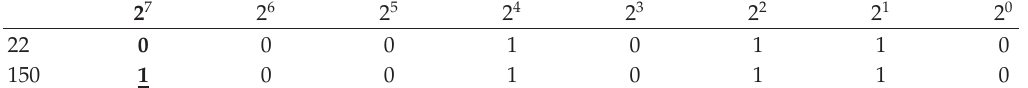
Table 3: Classification of three-variable Boolean